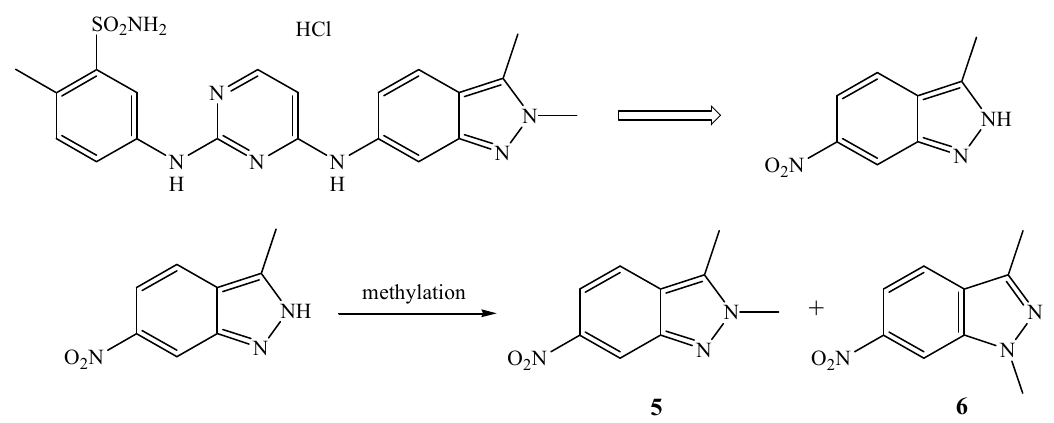
Figure 1. Pazopanib hydrochloride and critical stage of its manufacture.